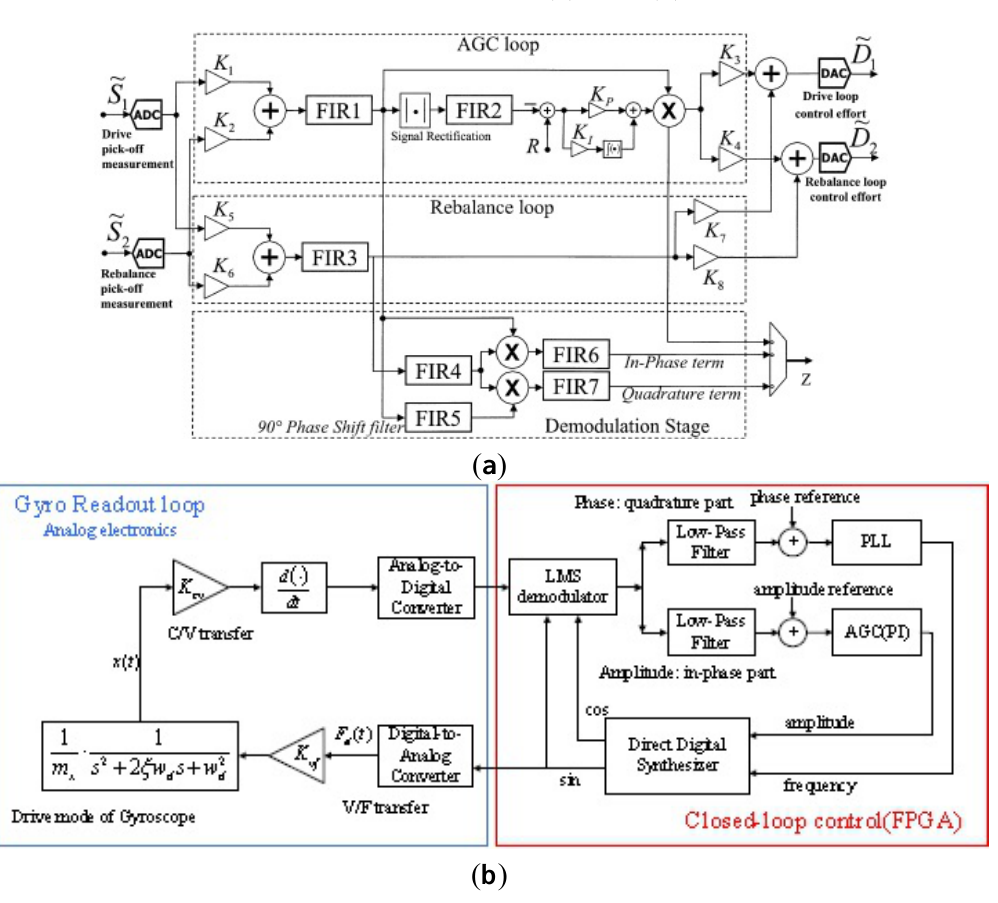
Figure 33. FPGA circuits. ( a ) JPL. ( b )